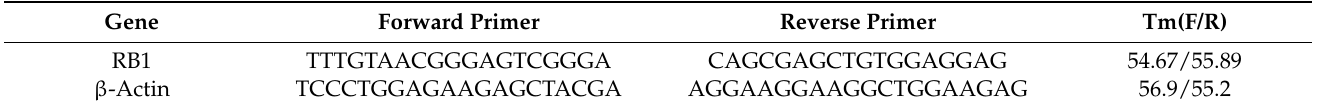
Table 2. Details of qPCR primers used in the